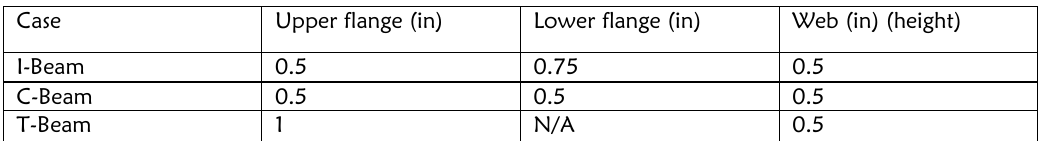
Table 1: Width of Geometrical